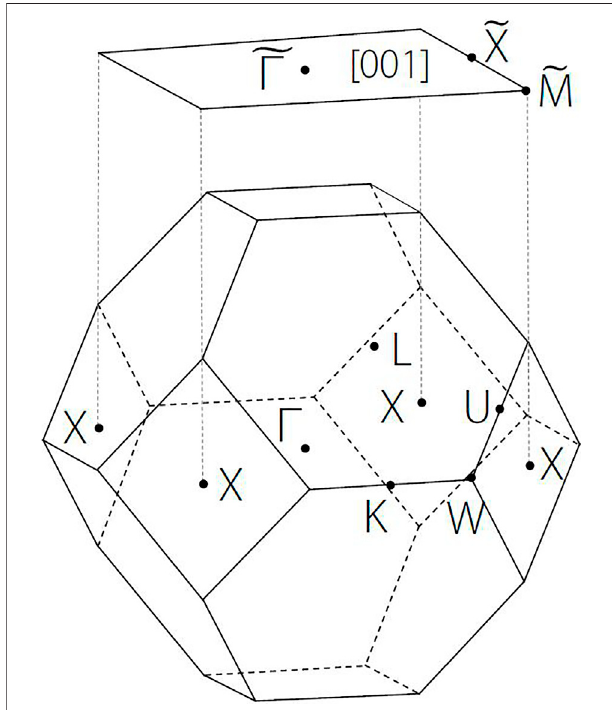
FIGURE 2 | Three-dimensional Brillouin zone (BZ) and the two- dimensional (001) surface BZ. The X, K, W, Y, L, Γ are the symmetry points of 3D BZ. Γ , X, and X points are projected to (cid:1) Γ , (cid:1) X , and (cid:1) M points of the (001) surface.